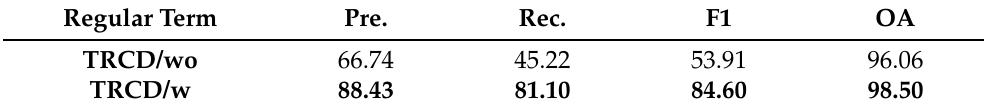
Table 8. Quantitative results of proposed objective function on LEVIR-CD with 4096 pairs of images. Regular Term Pre.